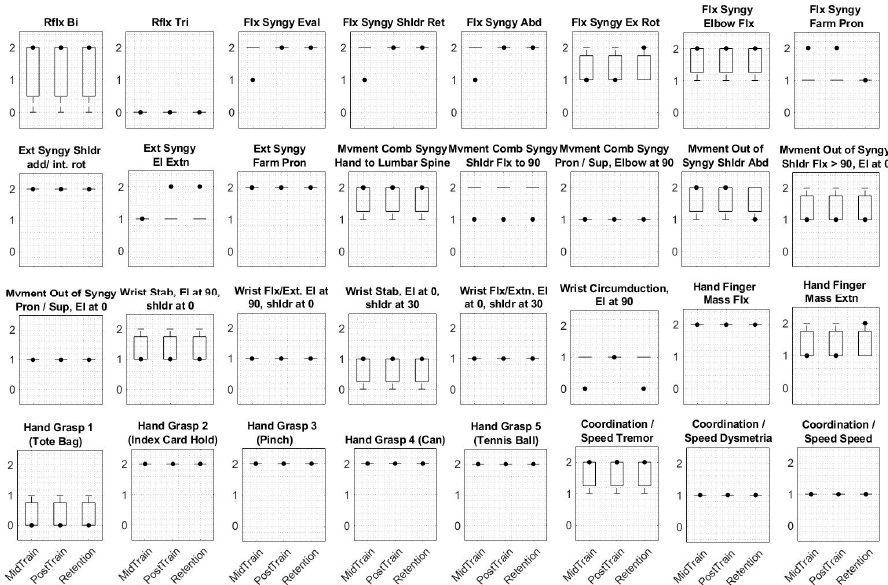
Figure 9. The boxplots for the Fugl-Meyer assessment (FMA) are shown. The three baselines are plotted as boxplots in subplots. The scores for mid training, post training, and retention (one month after six weeks of training) are shown as black-filled dots and are respectively named MidTrain, PostTrain, and Retention. The total scores of the four assessments were 45.33, 42, 47, and 46, respectively. The y axis does not have any unit. Abbreviations: Rflx, reflex; Bi: biceps; Tri, triceps; Flx, flexor; Syngy, synergy; Eval, evaluation; Shldr, shoulder; Ret, retraction; Abd, abduction; Ex, external;